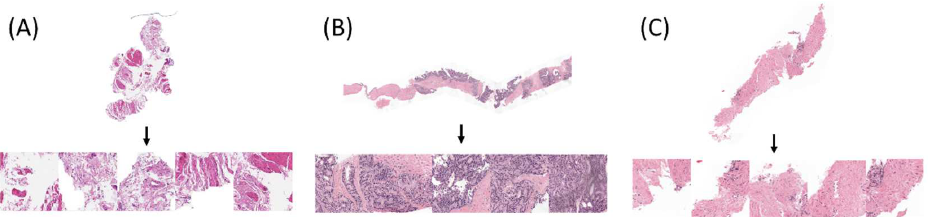
Figure 1. Original WSIs and their tiled images with different ISUP scores (( A ) ISUP score = 0, ( B ) ISUP score = 4, and ( C ) ISUP score = 5). Note: For brevity, only five tiled images are shown. ( A ) ISUP score = 0 and Gleason score = 0 + 0 at the Karolinska Institute; ( B ) ISUP score = 4 and Gleason score = 4 + 4 at Radboud University Medical Center; ( C ) ISUP score = 5 and Gleason score = 4 + 5 at Radboud University Medical Center. Abbreviations: whole slide image (WSI).